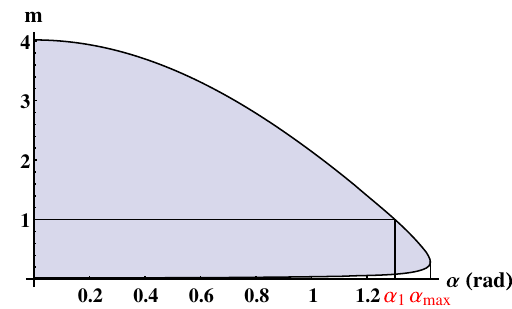
FIG. 10. A number of diffraction orders. Here α 1 is the minimal particle velocity for which only the first diffraction order exists; α is the maximal admissible angle [Eq. (50)]. It is plotted using max Eq. (51) for γ ¼ 7 , d= λ ¼ 2 .